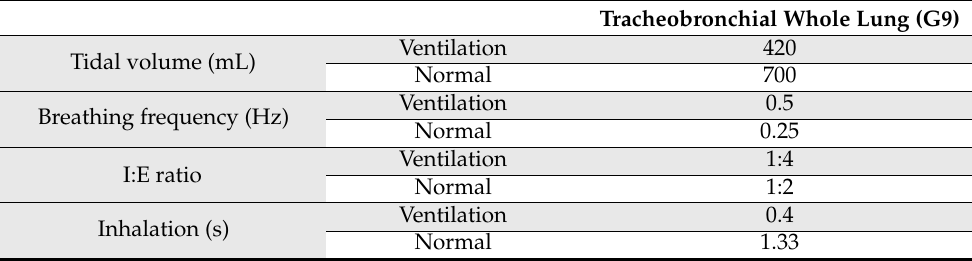
Table 1. Respiratory parameters of whole lung